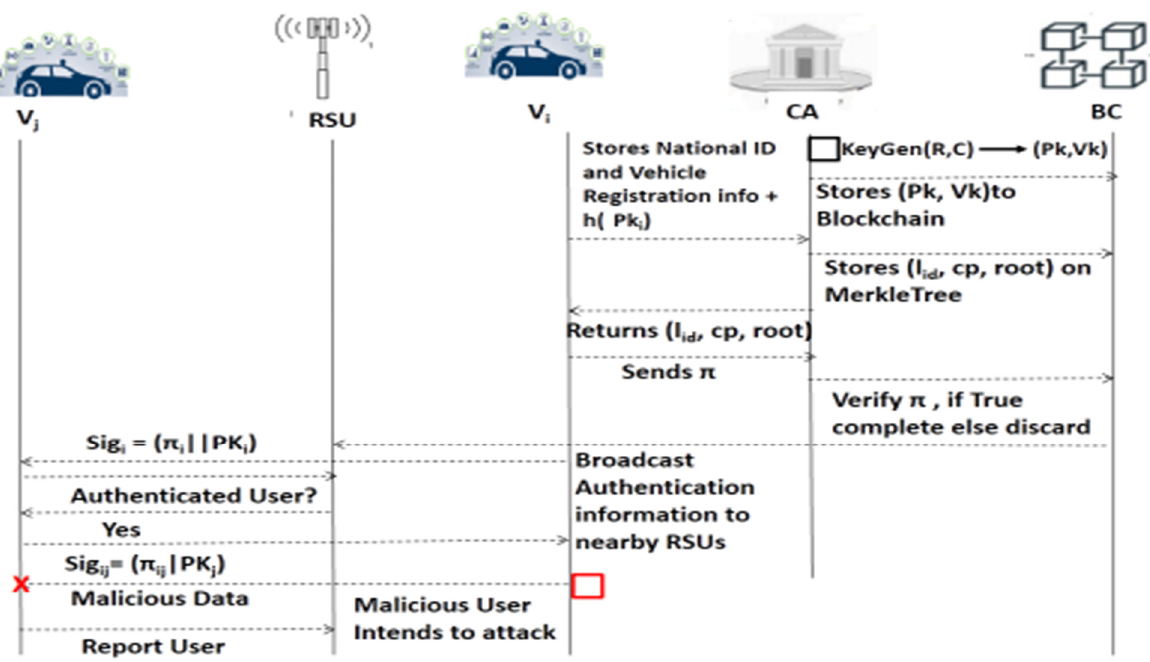
Figure 4. Overview of the Attack Scenario within Proposed System.